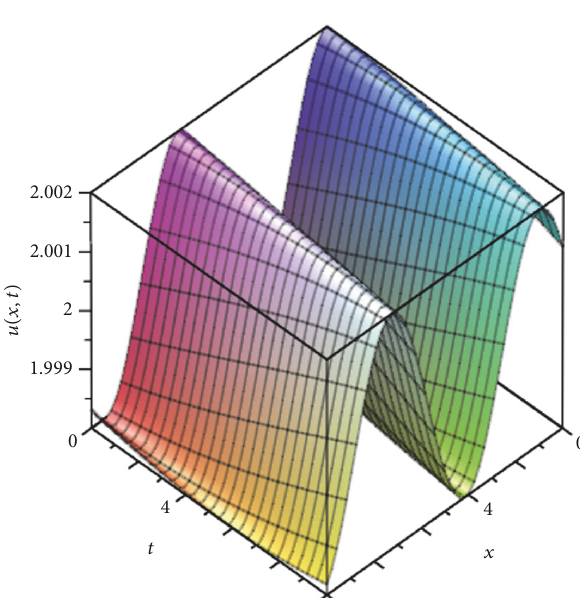
Figure 4: 3D plot of (46) with 𝑎 0 = 1 , 𝑎 1 = 1 , 𝑎 2 = 0.4 , 𝛾 = 1 , 𝛼 = 0.3 , 𝛽 =